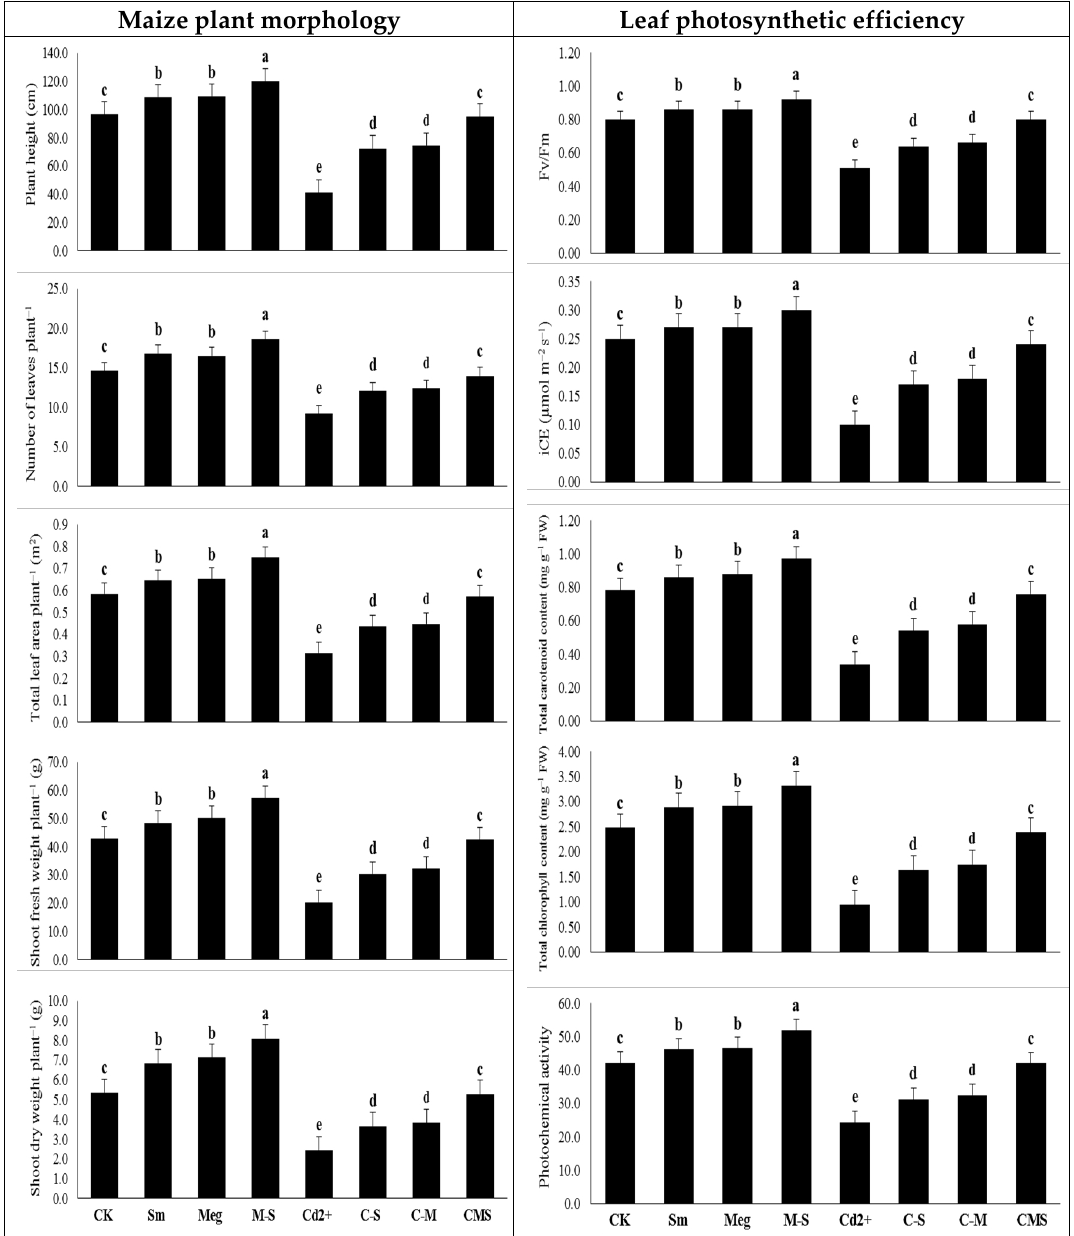
Figure 1. Response of maize plant morphology and leaf photosynthetic efficiency (carboxylation efficiency (iCE), PSII efficiency ( F v / F m ), total chlorophyll and carotenoid contents, and photochemical activity) to foliar application of silymarin (Sm), maize grain extract (MEg), or silymarin-enriched maize grain extract (MEg-Sm) under Cd stress. The same letters on the bars (mean ± SE) of the parameters indicate nonsignificant differences, whereas the significant differences are a result of different letters according to the least significant difference (LSD) test ( P ≤ 0.05). CK = control, Sm = silymarin, Meg = maize grain extract, M-S = silymarin-enriched maize grain extract, C-S = Cd+Sm, C-M = Cd+Meg, CMS = Cd+Meg+Sm.